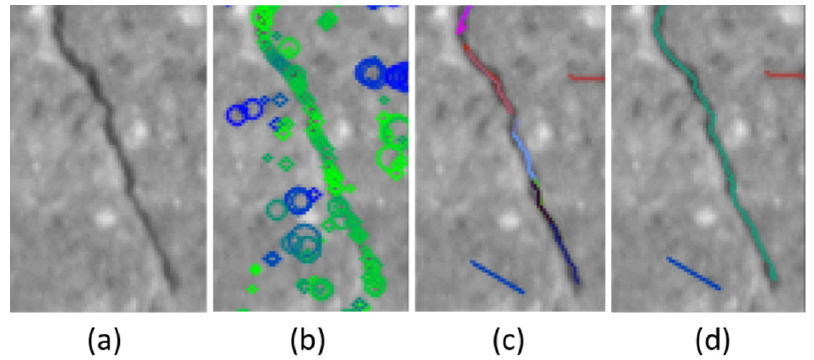
Figure 14. Detected crack pixels and generated crack segments: ( a ) input image, ( b ) detected crack pixels: blue colored circles represent crack pixels in a different direction than the green colored circles of crack pixels in one dominating orientation. The size of circle represents scale of the crack pixel, ( c ) represents initialized and extended crack segments, and ( d ) represents linked crack segments.